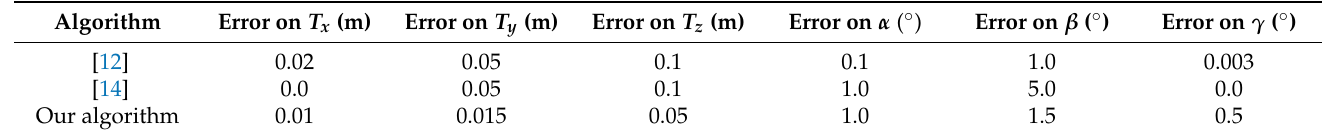
Table 4. Comparison between existing methods and our